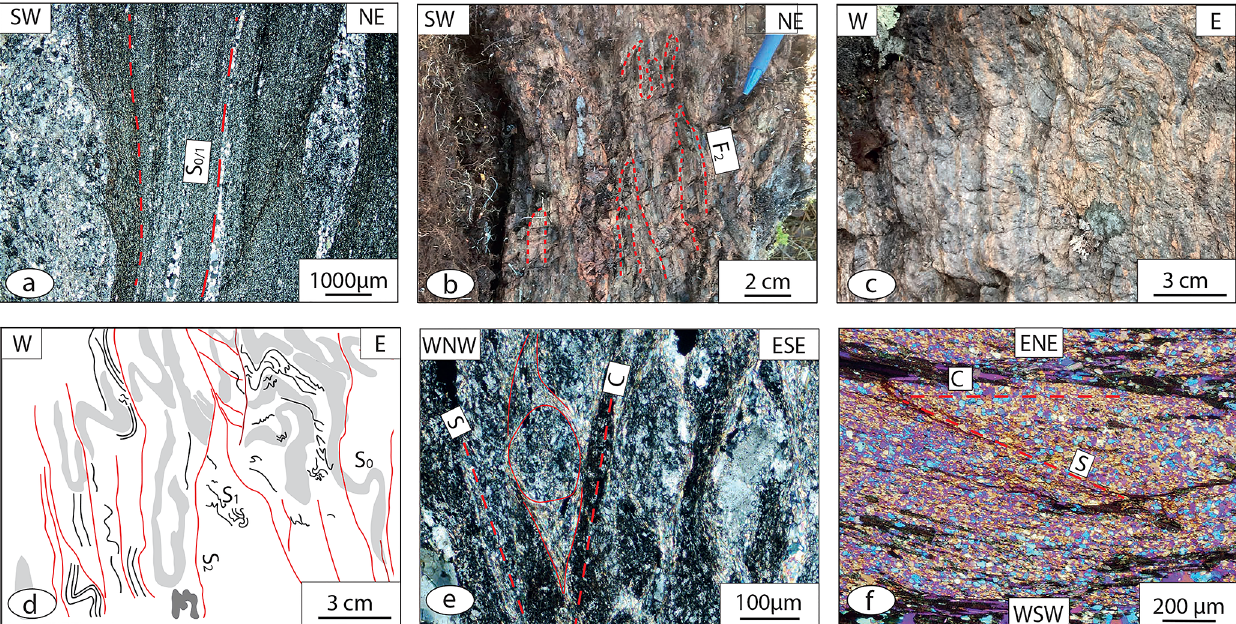
Figure 13. Thin-section photographs and field images/sketches of key localities in the Kaitum West key area. (a) Micrograph of S 0 /S 1 composite fabric in volcanosedimentary rock, X698952 Y7505460. (b) Isoclinal mesoscale folding of the S 0 /S 1 fabric (a) . (c) Volcanosedi- mentary unit showing a high-strain cleavage subparallel to S 0 . The S 0 /S 1 fabric is transposed into the direction of D 2 shear bands, X700402 Y7504830. (d) Simplified sketch of (c) . (e) SC fabric and asymmetric dextral sigma-sigmoid viewed along shallow south-plunging stretch- ing lineation, X702488 Y7504983. (f) SC fabric indicating sinistral kinematics viewed along steep, north-northwest-plunging stretching lineation, X693703 Y7519820. Coordinates: